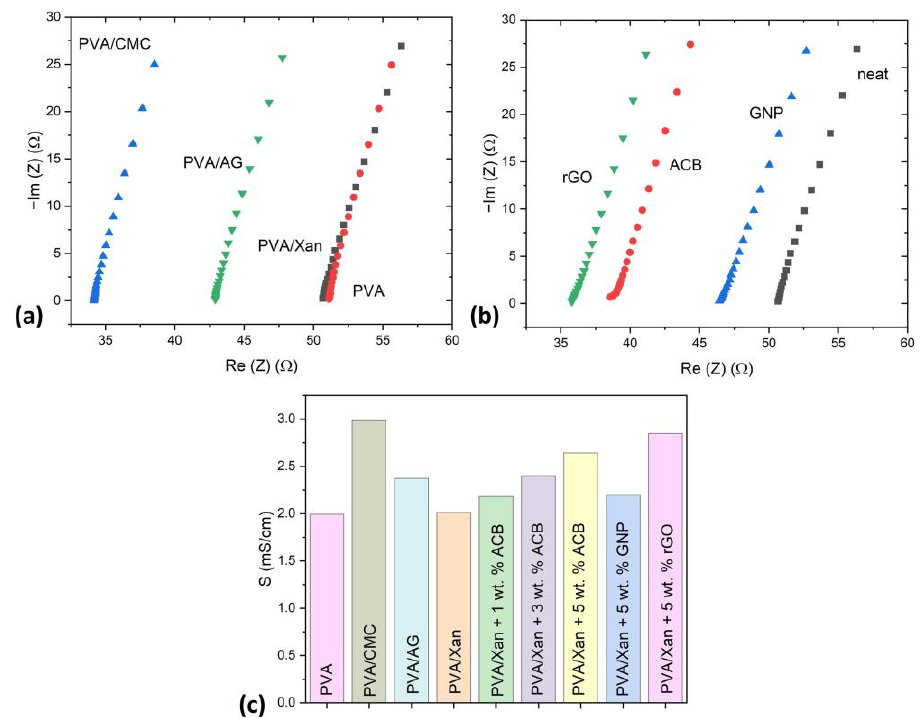
Figure 9. EIS measurements: ( a ) Nyquist diagram for hydrogels with different polysaccharide modifiers, ( b ) Nyquist diagram for PVA/Xan with 5 wt.% of different fillers and ( c ) conductivity for all samples.